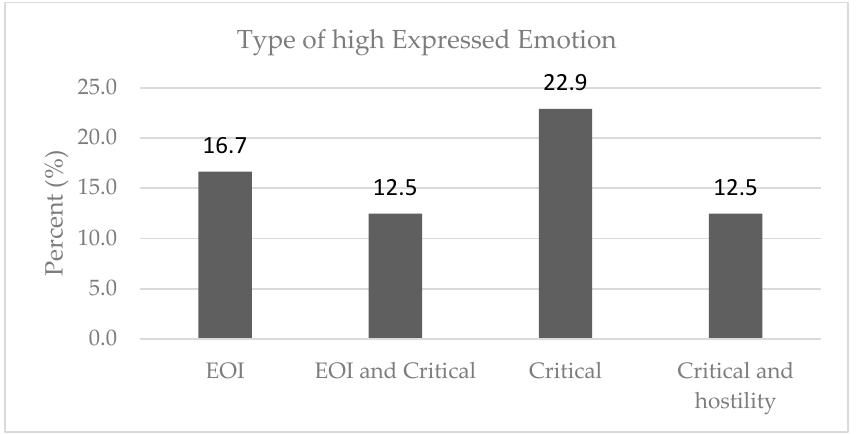
Figure 1. Percentage of each type of high expressed emotion (EOI = emotional overinvolvement). Table 2. World Health Organization Well-Being Index (WHO-5) and Brief COPE based on the relatives’ level of expressed emotion (EE) (N =